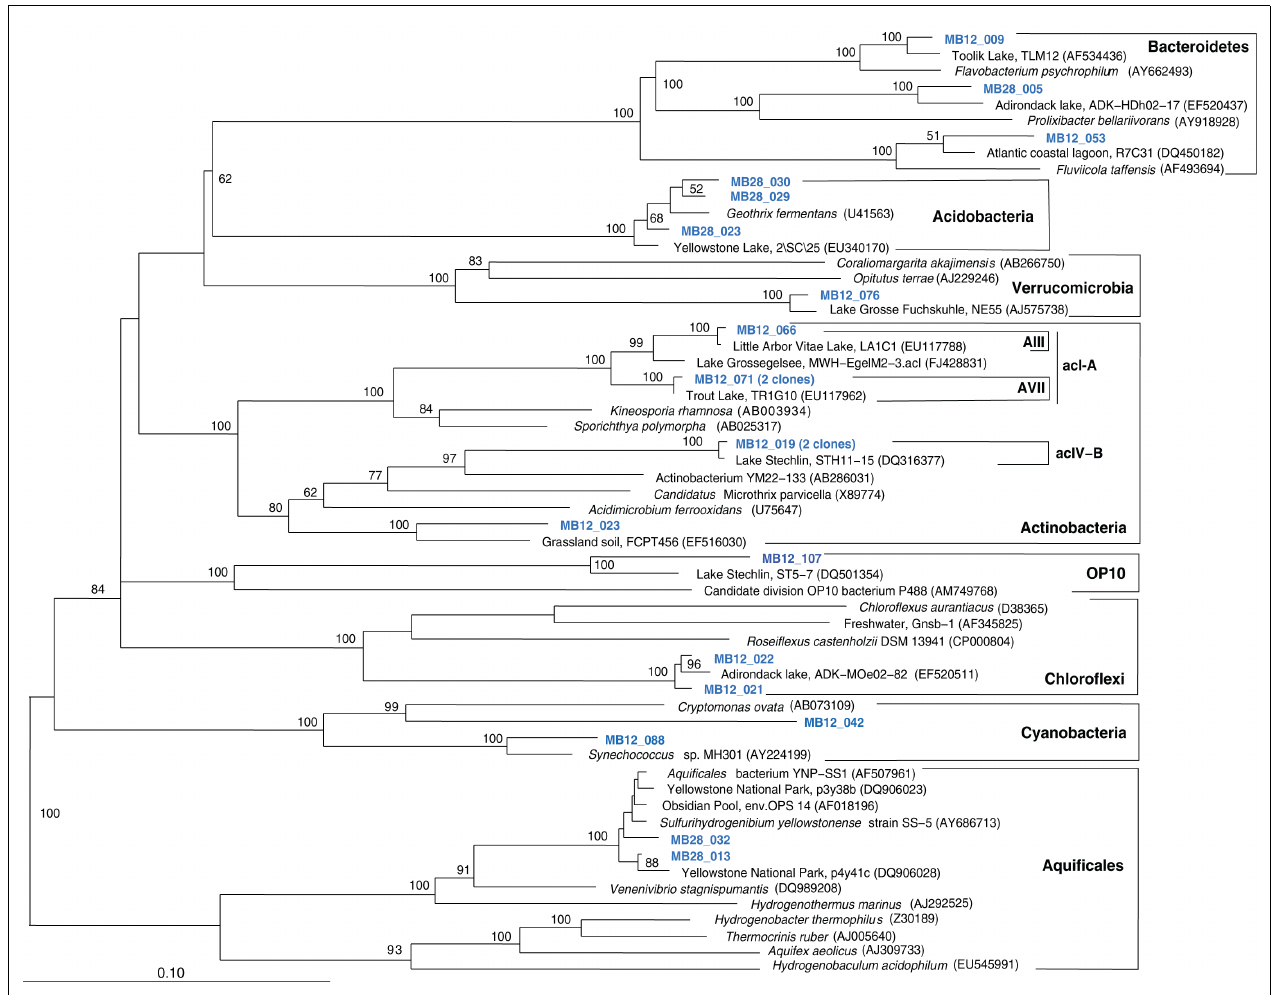
FIGURE 9 | Phylogeny of Mary BayWest 12 and Mary Bay Canyon 28 bacterial clones, except Proteobacteria, based on E. coli 16S rRNA gene nucleotide positions